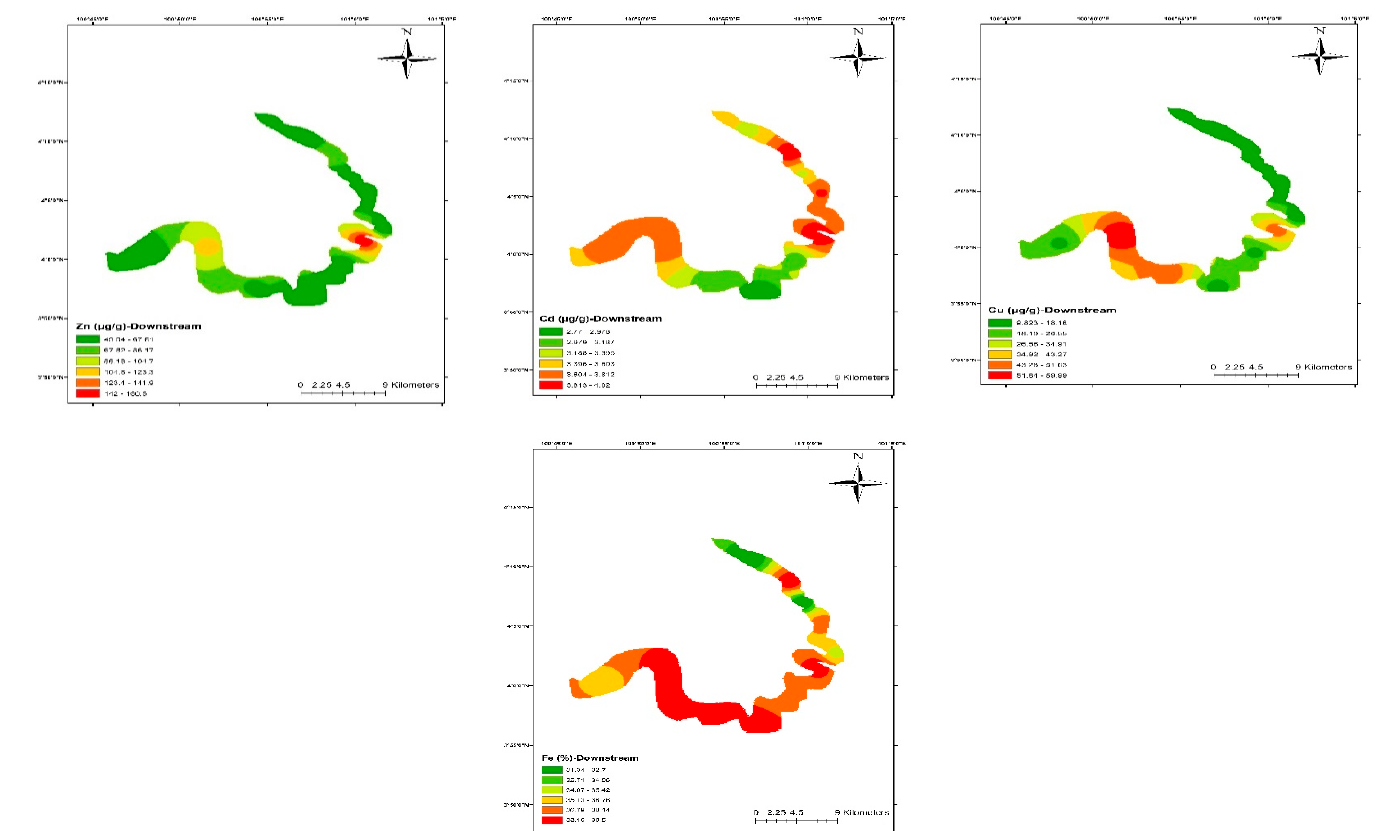
Figure 2. Geostatistical prediction maps of heavy metals in the surface sediment in upstream and downstream areas of the Perak River.